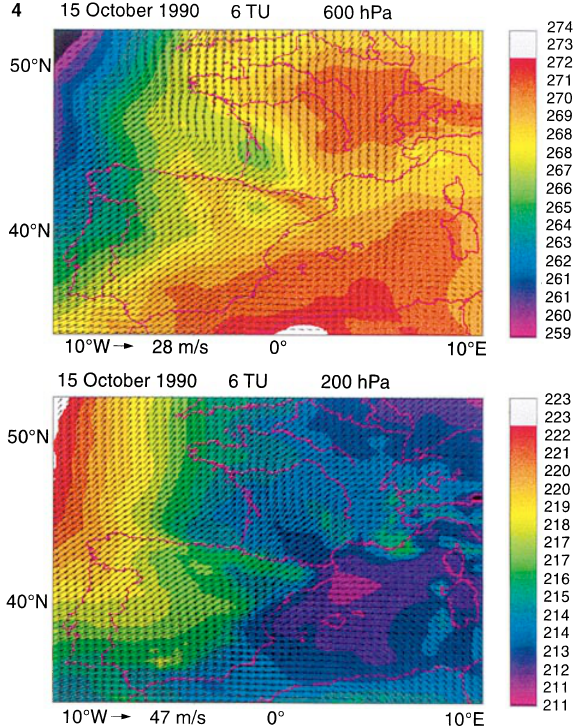
Fig. 4. Isolevels of temperature ( colors , in K) and horizontal wind ( arrows ) at 600 hpa ( top ) and 200 hPa ( bottom ) for 15 October 1990 at 06:00 UT (from Peridot Analysis of Me´ te´ o-France). The wind scale is given by the maximum of the field under each graph